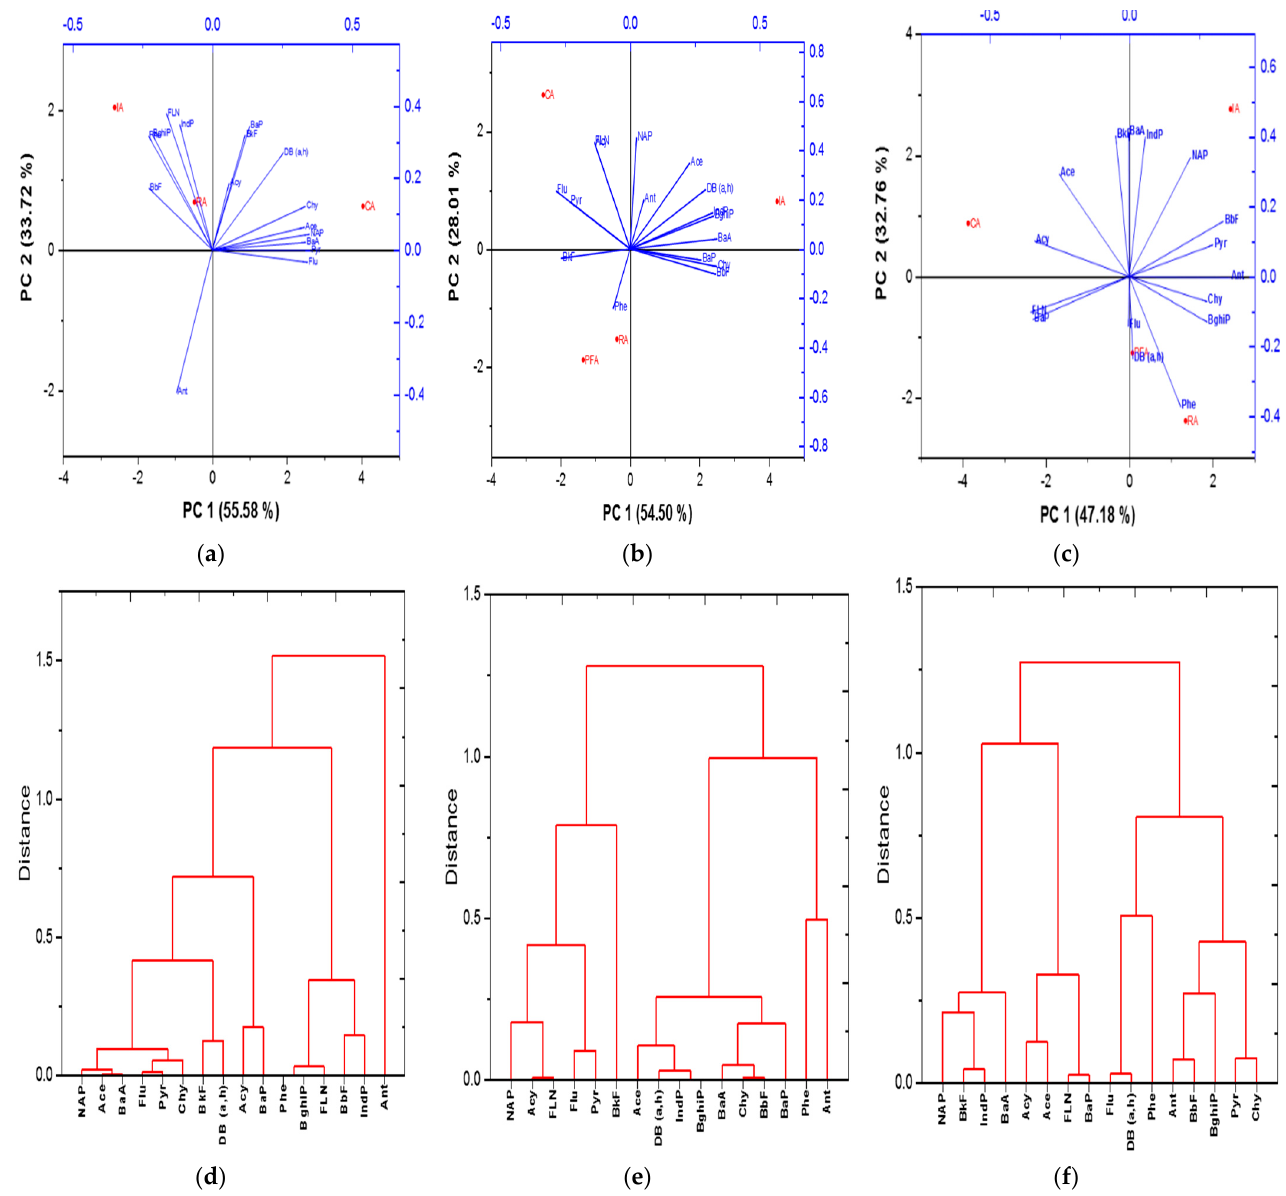
Figure 6. Principal component (PC) plots for PAHs in street dust during: ( a ) without lockdown, ( b ) partial lockdown, and ( c ) complete lockdown; and hierarchical cluster (HC) plots for PAHs in street dust during: ( d ) without lockdown, ( e ) partial lockdown, and ( f ) complete lockdown.